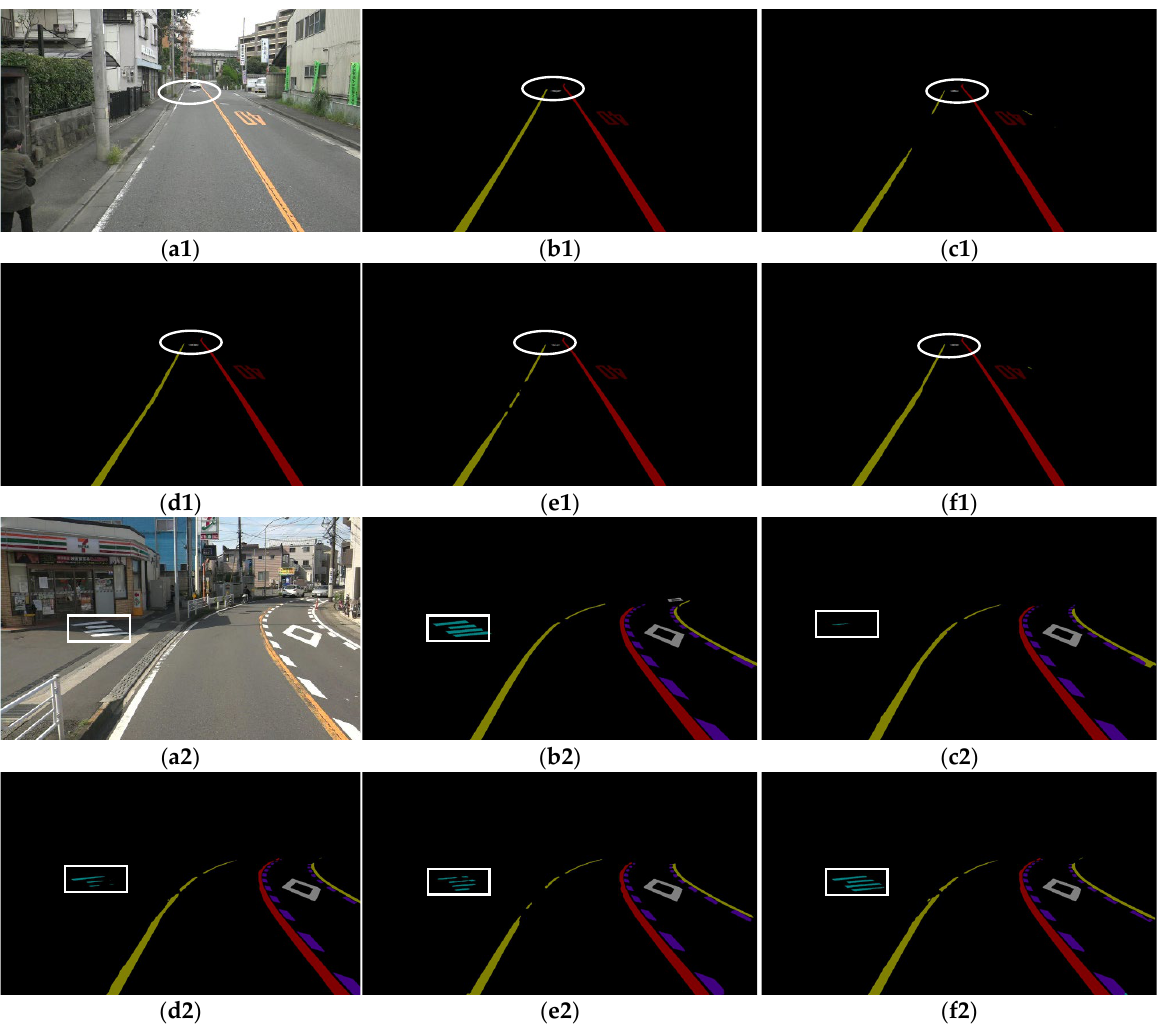
Figure 9 . Visual results on two test images of the RMD: ( a1 , a2 ) original test image; ( b1 , b2 ) ground truth; ( c1 , c2 ) segmentation result of U-Net; ( d1 , d2 ) segmentation result of PSPNet; ( e1 , e2 ) segmentation result of DeepLabV3+; ( f1 , f2 ) segmentation result of MSA-DCNN. The white frameworks highlight the performance differences of four models.